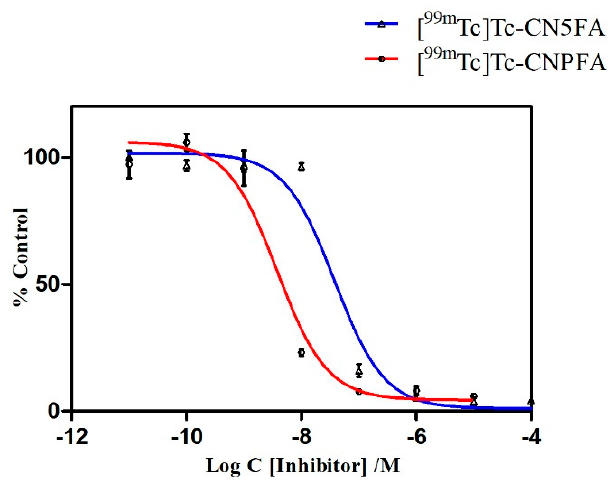
Figure 3. In vitro competitive binding curves of [ 99m Tc]Tc-CN5FA and [ 99m Tc]Tc-CNPFA.